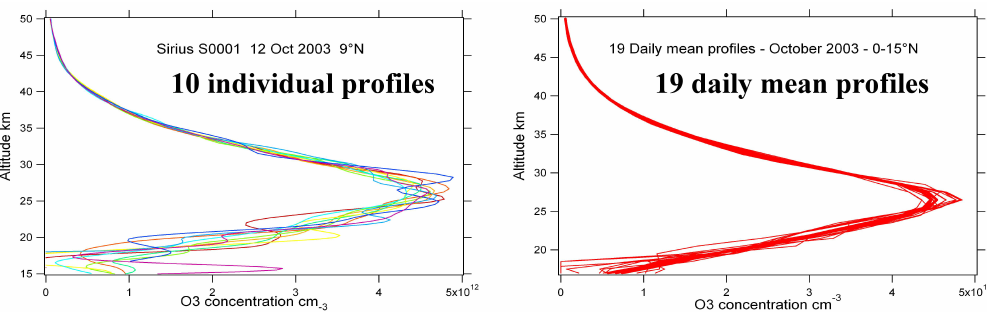
Fig. 23b. Left: ozone vertical profiles obtained with the occultation of Sirius at 9 ◦ N and 10 different longitudes, obtained in a single day (9 October 2003). Right: 19 daily mean profiles obtained with Sirius during the month of October 2003. - 89 -